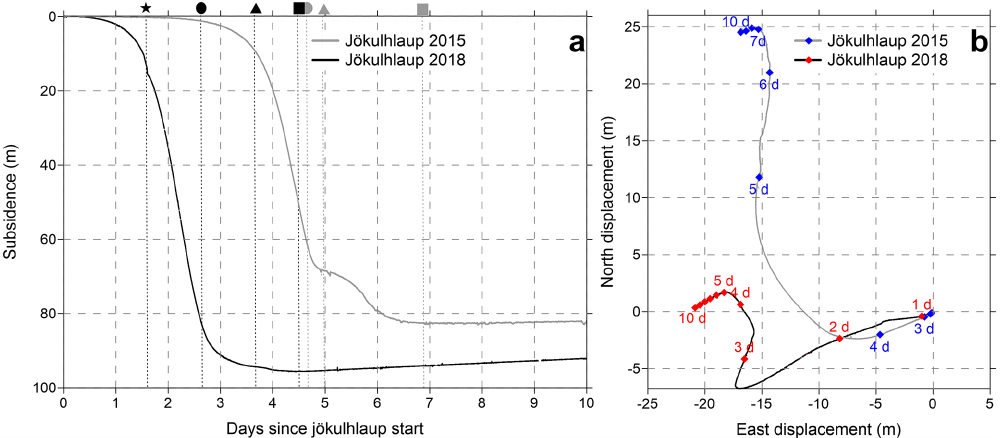
Figure 10. (a) The subsidence of the GNSS station in the ESC (exact location shown in Fig. 7) during the jökulhlaups in 2015 (grey profile) and 2018 (black). The symbols (star, circles, triangles and squares) mark timestamps of events discussed in Sect. 4.3. (b) A planar view showing the horizontal track of the station during the jökulhlaup relative to its position at the onset of the jökulhlaup. Blue and red diamonds show positions of the station at 24h intervals during the 2015 and 2018 jökulhlaups,